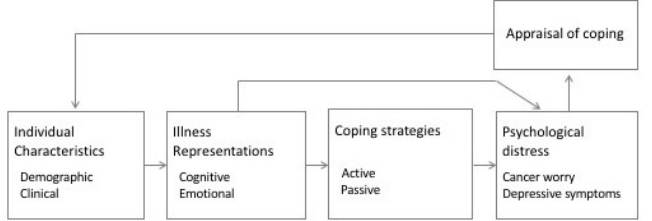
Figure 1. Conceptual model of predictors of psychological distress, adapted from Freemann-Gibb [21].